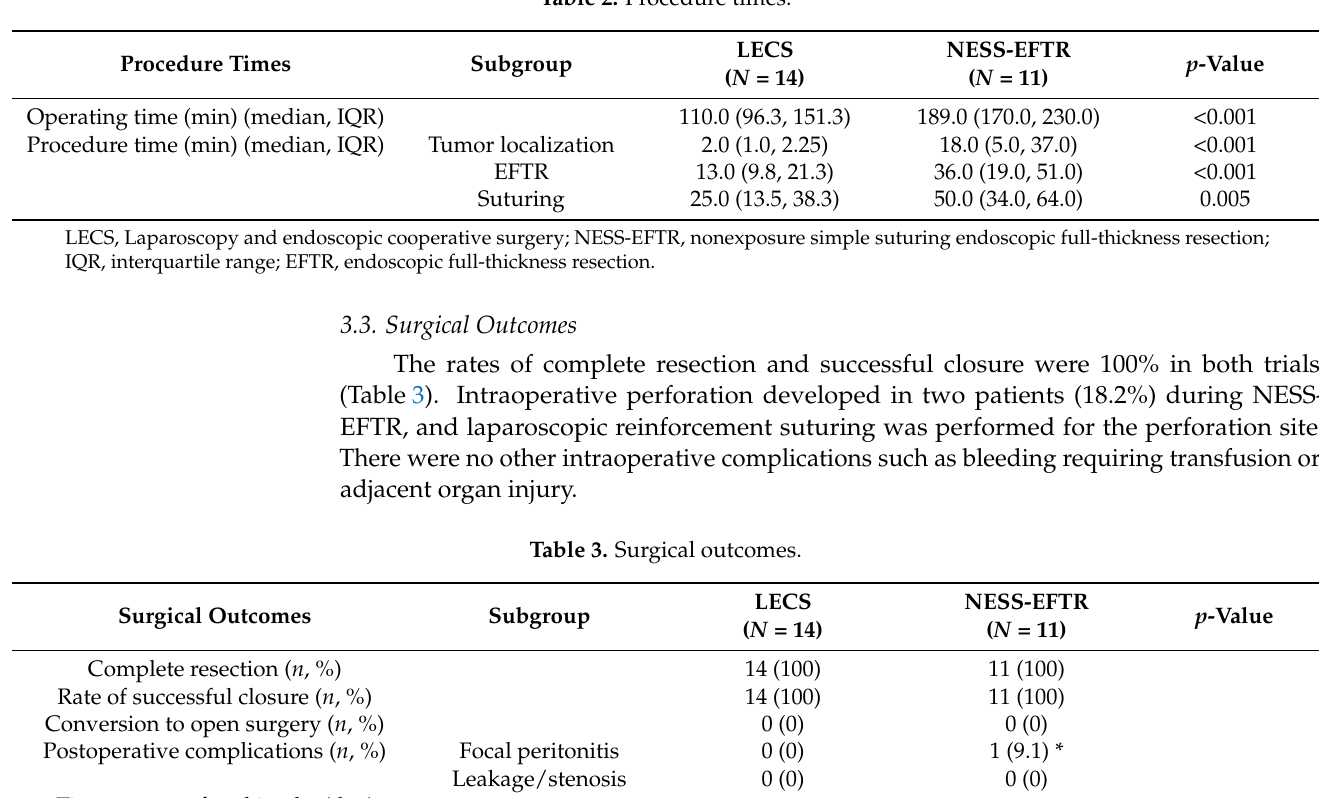
Table 2. Procedure times.